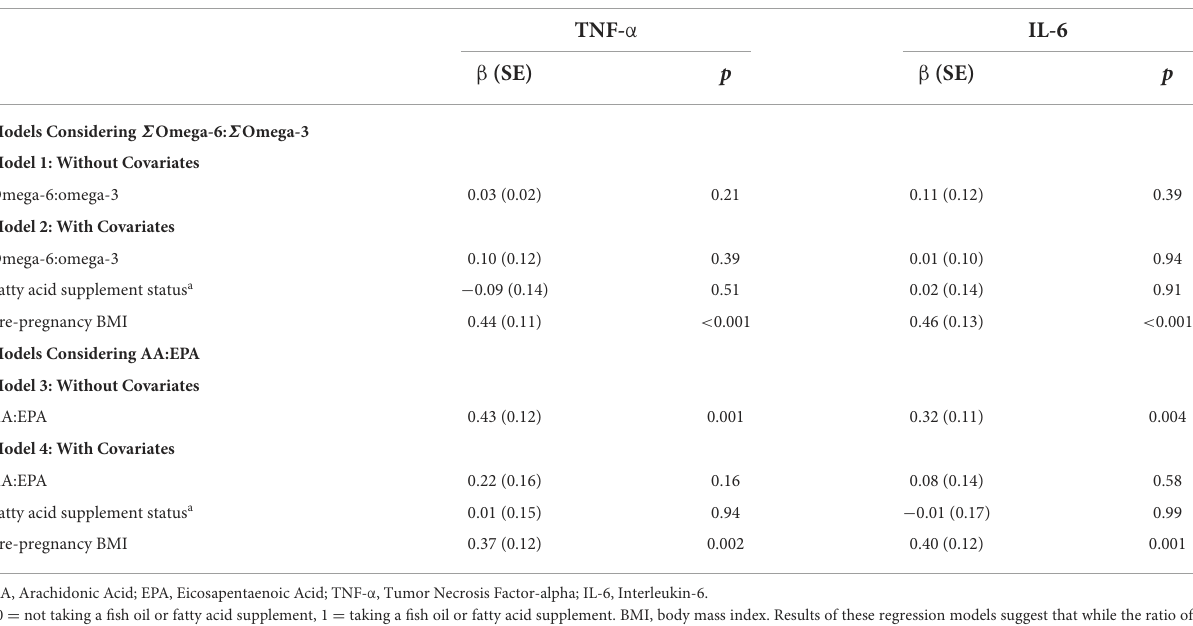
TABLE 4 Results from regression models relating omega-6:omega3 metrics and pro-inflammatory cytokines ( N = 68).